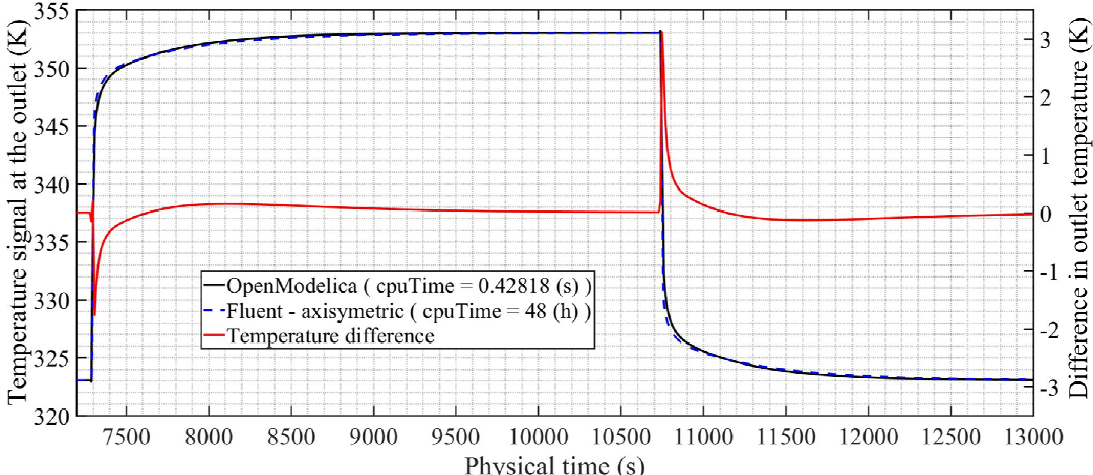
Figure 22. Comparison of Case 1 and Case 2 (with constant mass flow of 282.74 kg/s).